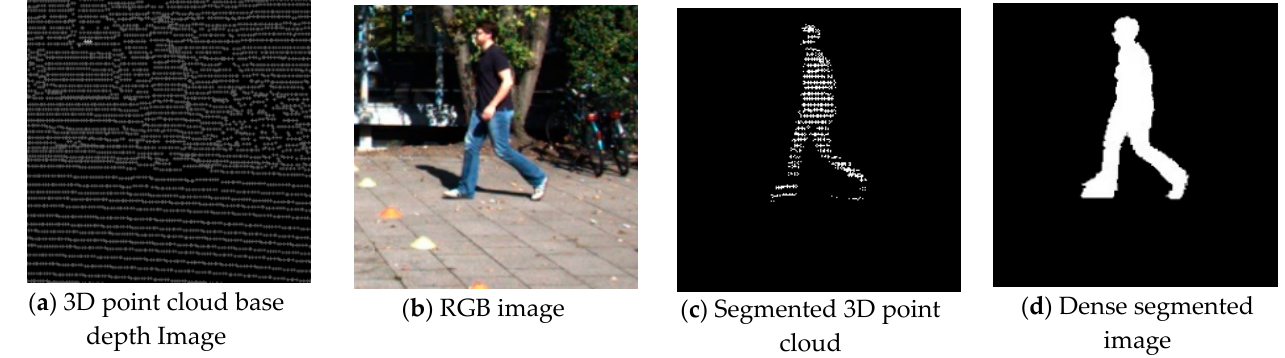
Figure 6. Depth image and RGB image using KITTI dataset and ground truth for the encoder-decoder model learning.